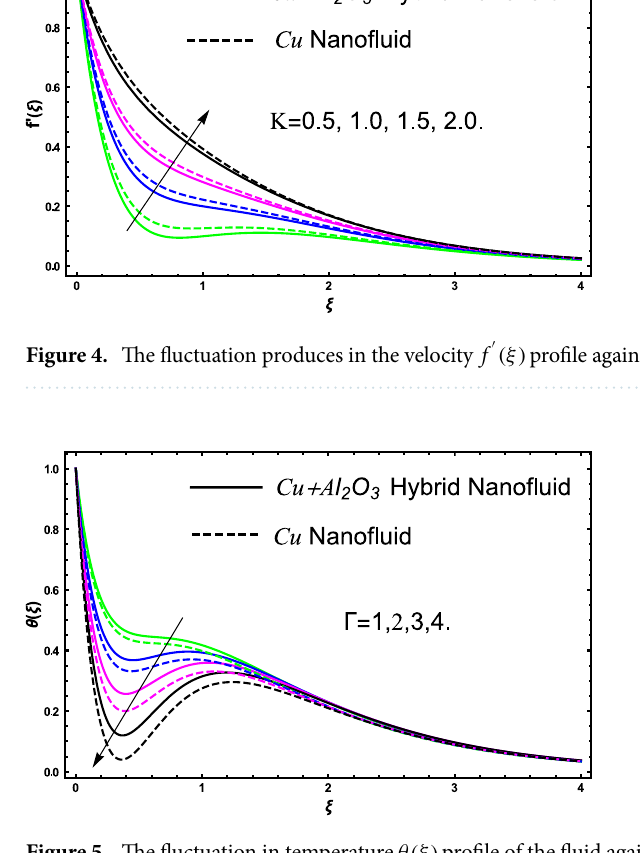
Figure 5. The fluctuation in temperature θ(ξ) profile of the fluid against elevated values of Ŵ .